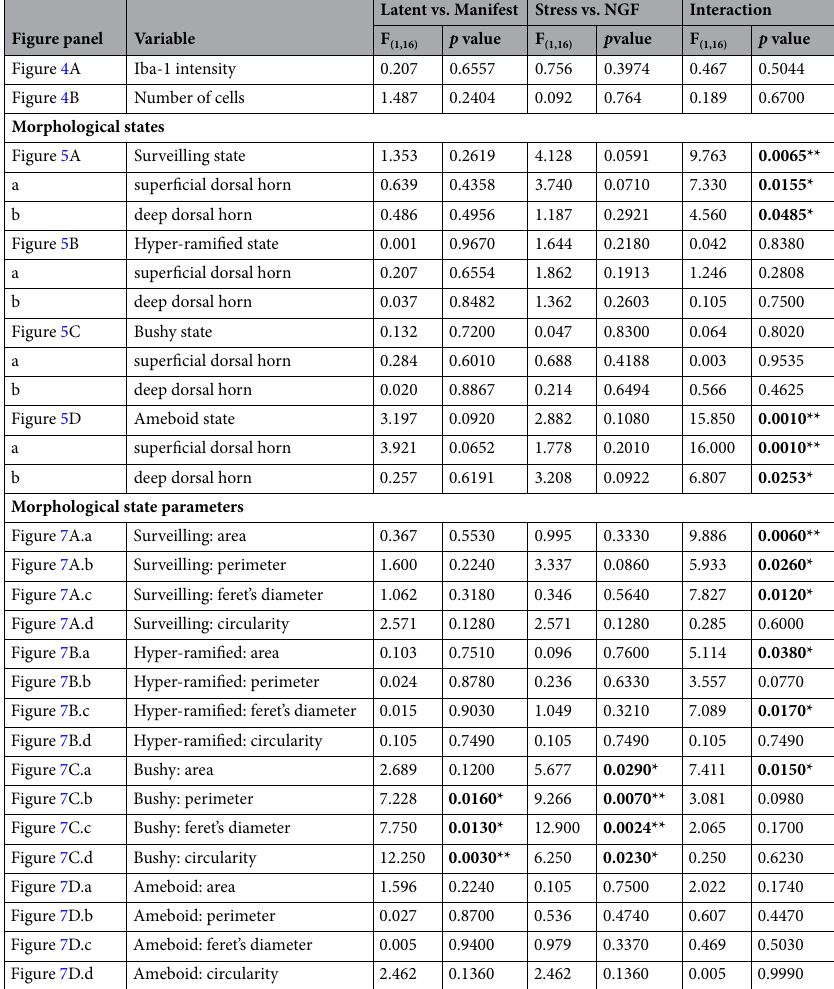
Figure 7C.a Bushy: area Figure 7C.b Bushy: perimeter Figure 7C.c Bushy: feret’s diameter Figure 7C.d Bushy: circularity Figure 7D.a Ameboid: area Figure 7D.b Ameboid: perimeter Figure 7D.c Ameboid: feret’s diameter Figure 7D.d Ameboid: Table 1. Comparison of factors state (latent vs. manifest sensitization) and model (adolescent stress vs. two NGF). The staining intensity and background was measured for each ROI. The background was subtracted, and the mean staining intensity was calculated (Fig. 4A). The number of cells were counted for each ROI and averaged across the four ipsilateral ROIs within each animal (Fig. 4B), separately per morphological state (Fig. 5A–D). Morphological parameters were obtained for each microglia cell (Fig. 7A–D). The statistics were performed using two-way ANOVA for two main effects and their interaction, significance is indicated by *. ROI, region of interest; Iba-1, ionized calcium binding adapter molecule 1.